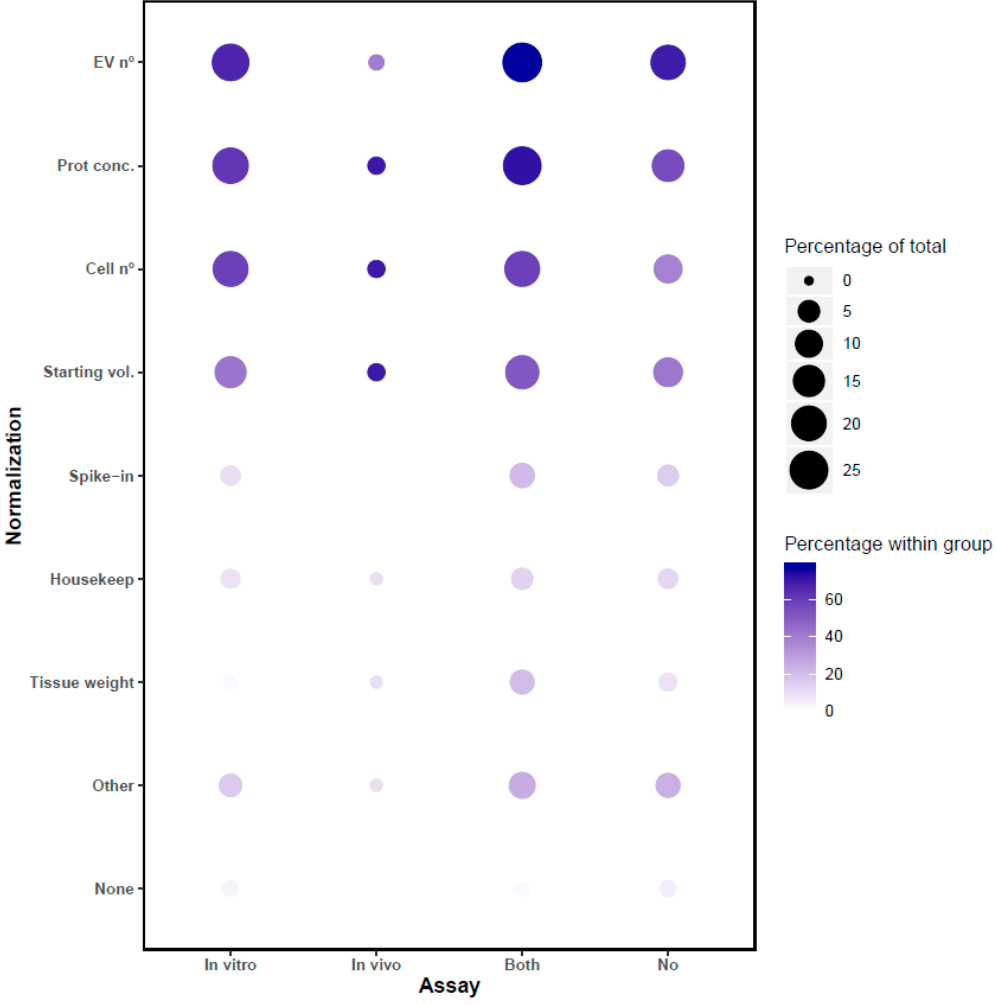
Figure 7. Techniques to normalize the use of EVs for downstream applications depend on whether the researchers perform in vitro assays, in vivo assays, both types of assays, or neither. Categories in the y -axis are organized from more to less frequent normalization method in the in vitro group. Balloon size represents the percentage calculated using as total the number of respondents of this question (323). Balloon color intensity indicates the percentage calculated using the number of respondents within each group (111 only in vitro, 10 only in vivo, 111 perform both types of assays, and 91 none). Please note that this question had the possibility of multiple answers. Abbreviations: EV number (EV nº), Internal molecule (Housekeep), others (absorbance at 280 nm, lipid amounts, miRNAs, mixture of peptides, etc.), Producing cell number (cell nº), Protein concentration (Prot conc.), Spike-in molecule (Spike-in), Volume of medium or biofluid (Starting vol.) Tissue source weight (Tissue weight).